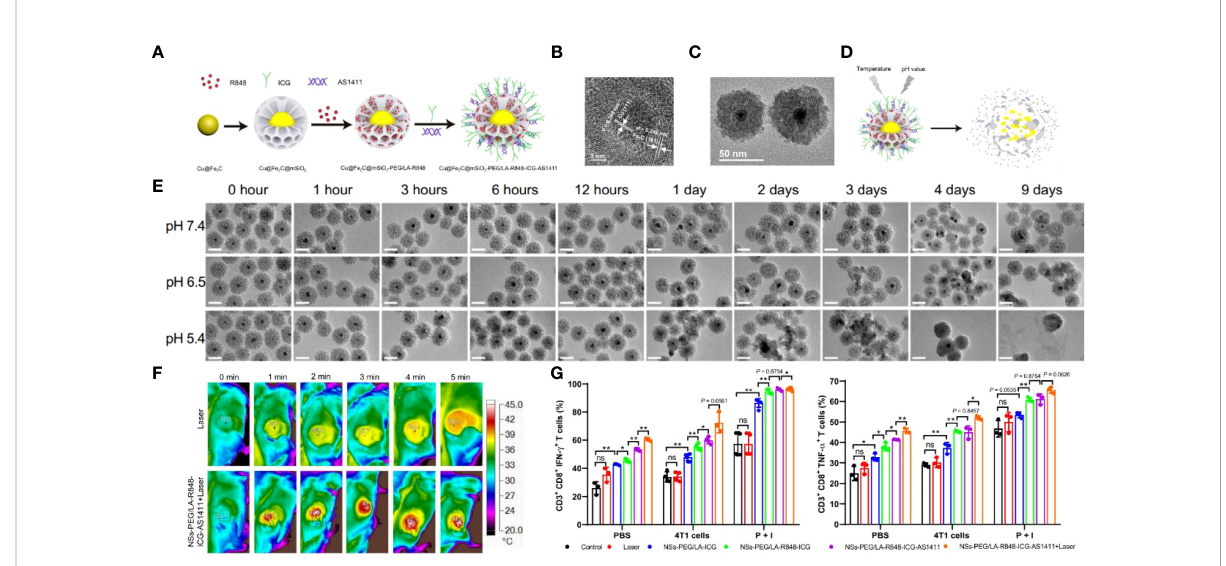
FIGURE 4 (A) Schematic diagram about the Cu@Fe (B) HRTEM images of Cu@Fe (C) TEM of 2 C@mSiO 2 -PEG/LA-R848-ICG-AS1411 nanozymes. 2 C NPs. Cu@Fe 2 C@mSiO 2 NSs. (D) Schematic representation of degradation and drug release from temperature and pH-controlled Cu@Fe 2 C@mSiO 2 - PEG/LA-R848-ICG-AS1411 nanoenzymes. (E) TEM images of Cu@Fe 2 C@mSiO2 under different environments (pH=7.4, 6.5, 5.4) at different times. (F) Thermal infrared imaging of tumor-bearing mice after intravenous injection of PBS and Cu@Fe2C@mSiO2-PEG/LA-R848-ICG-AS1411 under 808 nm laser irradiation. (G) Flow cytometric statistical analysis of CD3 + CD8 + IFN- g + and CD3 + CD8 + TNF- a + in mouse splenocytes after receiving different treatments (n = 3, ns, no signi fi cance, *p < 0.05, **p < 0.01 (87). Reprinted with permission from Ref.